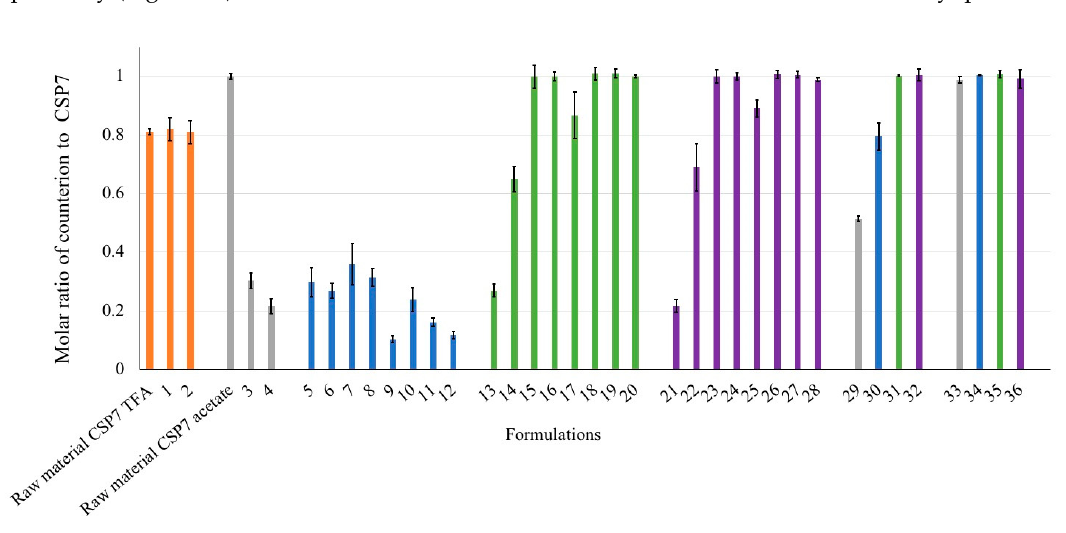
Figure 10. Molar ratio of counterions to CSP7.